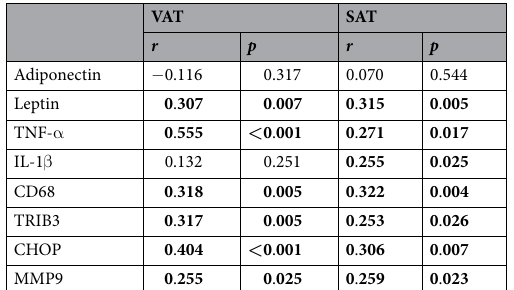
adjustment for BMI. ANGPTL2 mRNA was not correlated with adipocyte size in VAT or SAT (Supplementary Fig. 1). Association between ANGPTL2 mRNA expression and the expression of other gene transcripts in human adipose tissue.